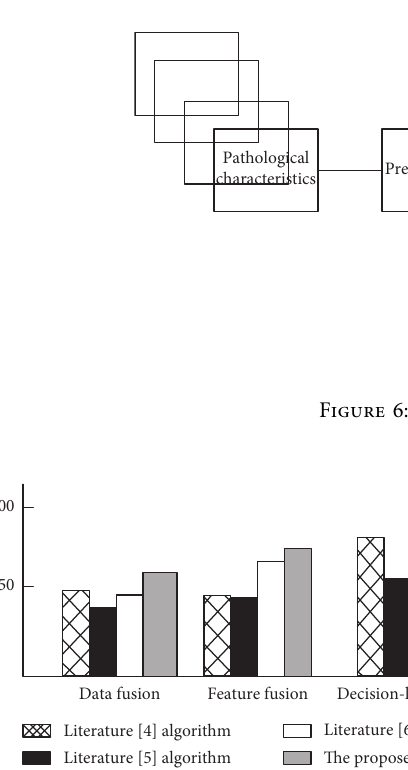
Figure 7: Comparison results of the fusion of patient character- istics and pathological